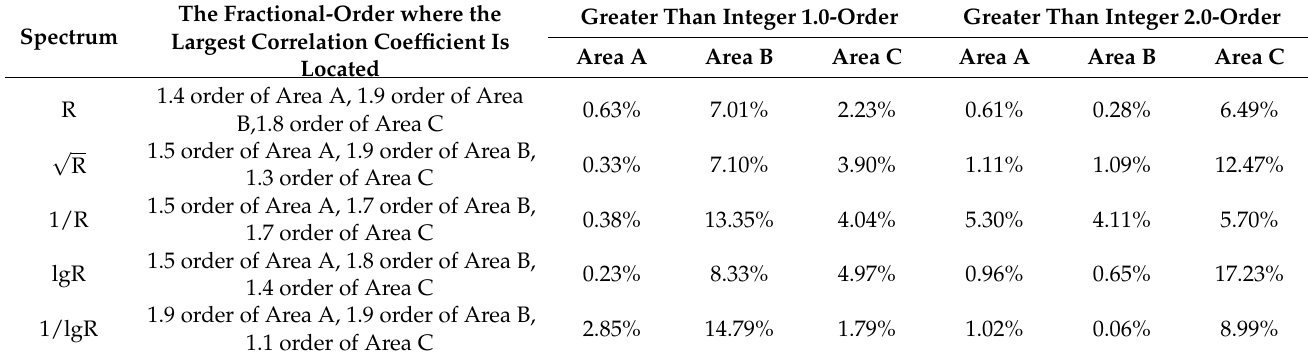
Table 7. The absolute value of the fractional-order maximum correlation coefficient is greater than the absolute value of the integer-order maximum correlation coefficient (correlation coefficient improvement